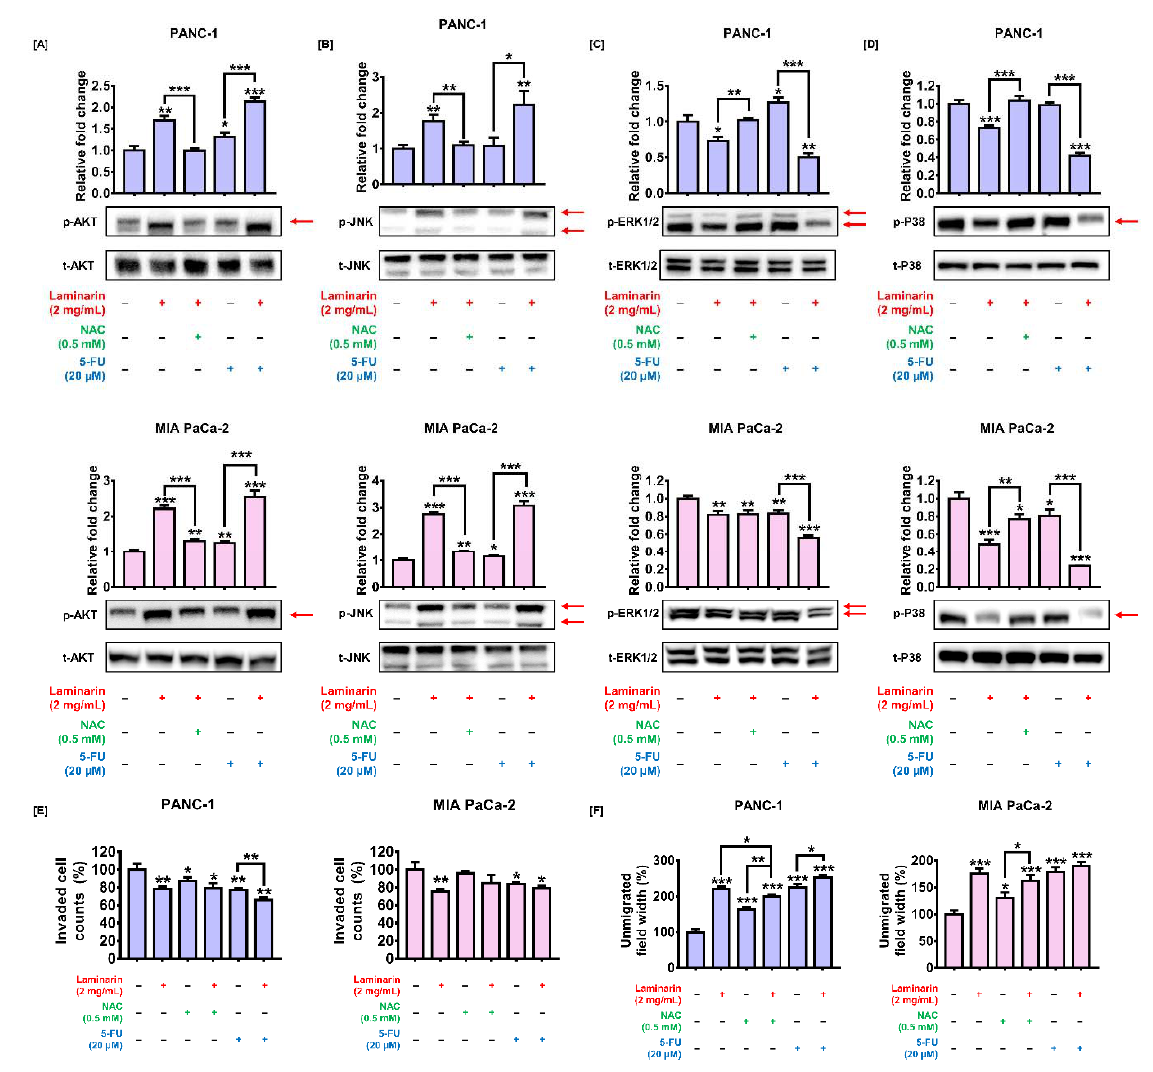
Figure 7. Synergistic ability of laminarin with 5-FU and effects of laminarin-induced ROS on cell invasion. ( A – D ) Effects of laminarin (2 mg/mL) alone or with NAC (0.5 mM) or 5-FU (20 µ M) on phosphorylation ( A ) AKT, ( B ) JNK, ( C ) ERK1/2, and ( D ) P38. Red arrows indicate each band of protein which is quantified. ( E , F ) Cell invasion and migration after incubation with laminarin alone or with NAC or 5-FU. (* p < 0.05, ** p < 0.01, and *** p < 0.001). All experiments were